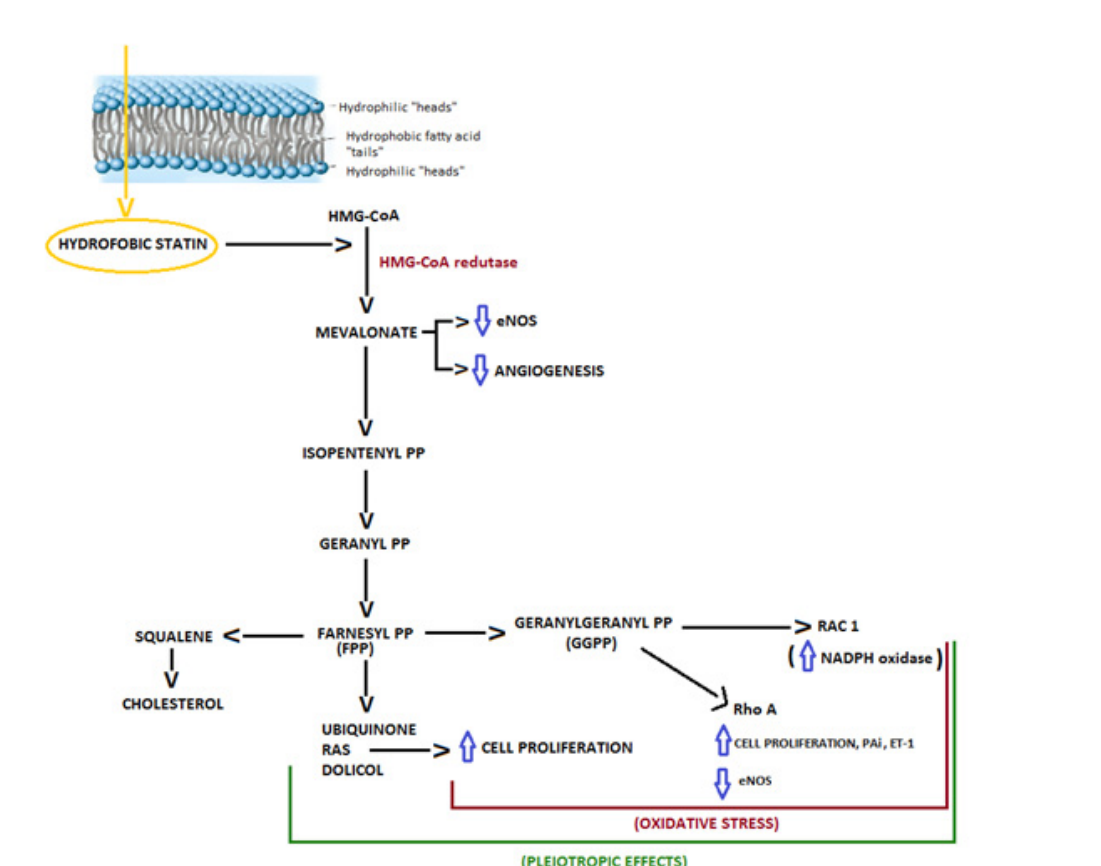
Fig. 2 – Action mechanism of the